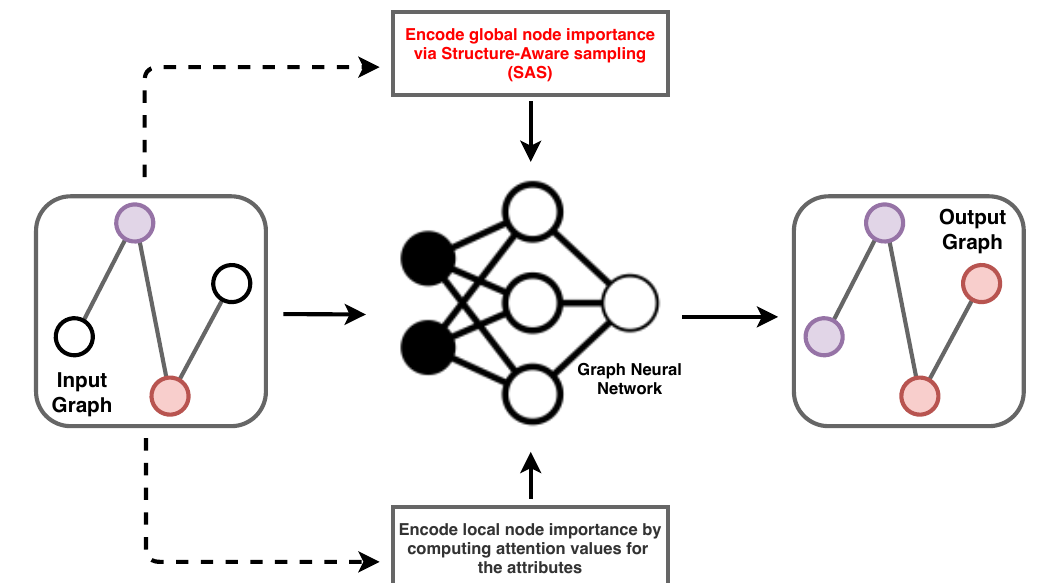
Figure 1. A description of our proposed methodology for the transductive learning case. We perform node sampling using the global structure of the graph. The input to the Graph Neural Network (GNN) is a partially labelled input graph. The global graph structure and node attributes are used to train our network. The output graph is fully labelled, where the colours of the node denote class